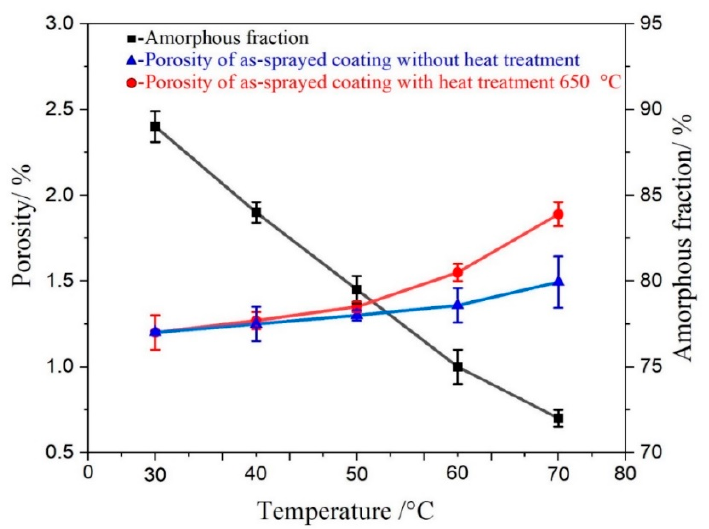
Figure 4. Comparison of the porosity and amorphous phase fraction of the coatings deposited under the conditions of 30 °C, 40 °C, 50 °C, 60 °C and 70 °C.